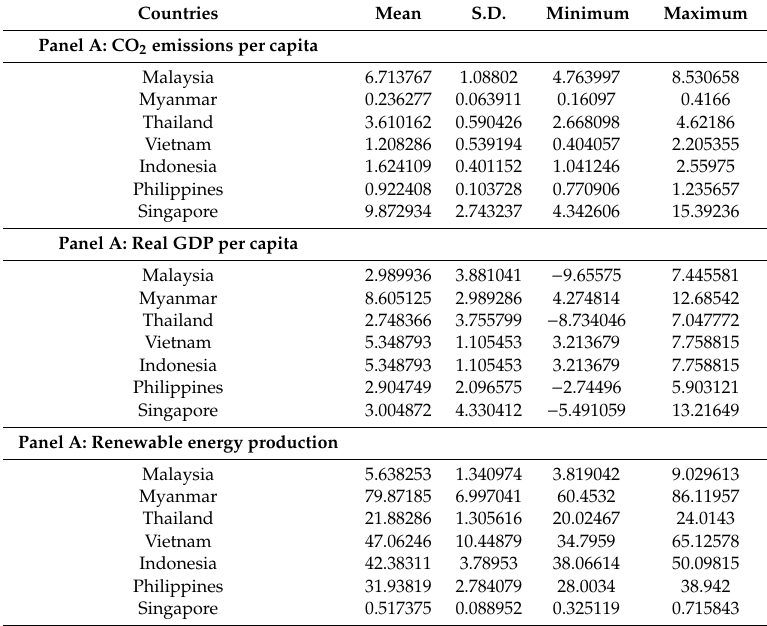
Table 2. Descriptive statistics for CO 2 emissions, real GDP, and renewable energy